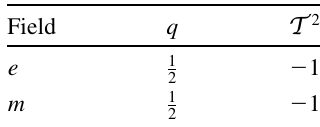
TABLE VI. U ð 1 Þ (cid:1) Z T